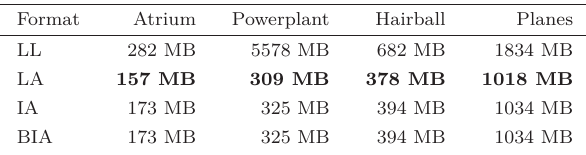
Table 4 Data usage for different deep image